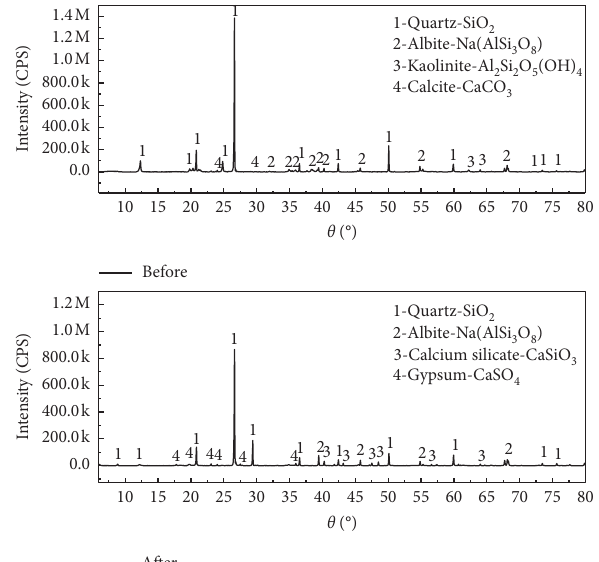
Figure 15: XRD diffraction pattern of specimen surface before and after